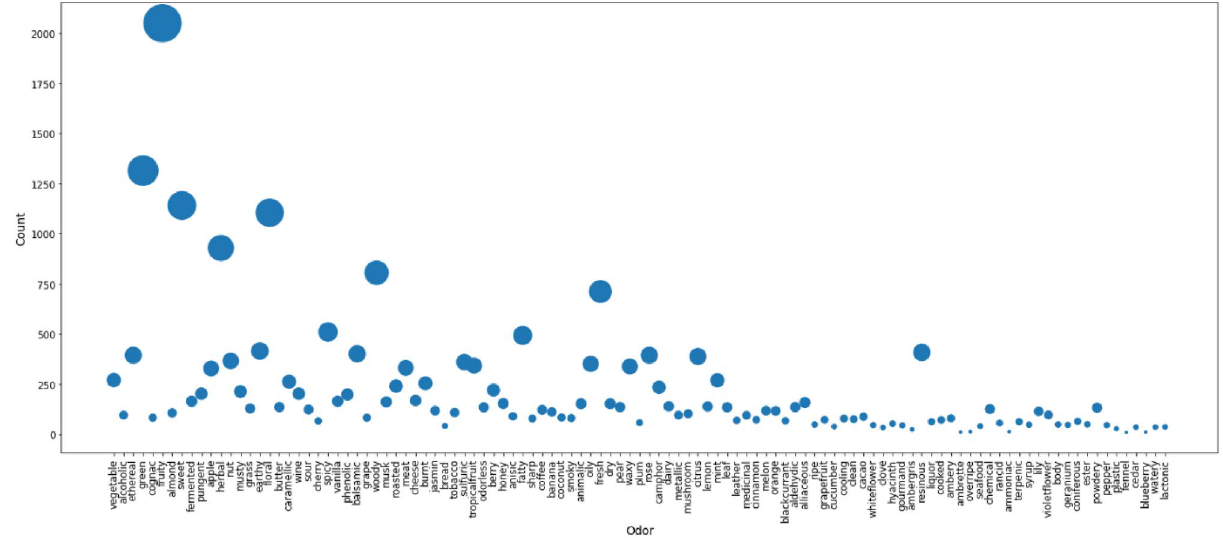
Figure 4. A scatter plot representing the number of samples in each of the 109 unique odor classes.The size of each point in the plot is proportional to the magnitude of the number of samples in that odor